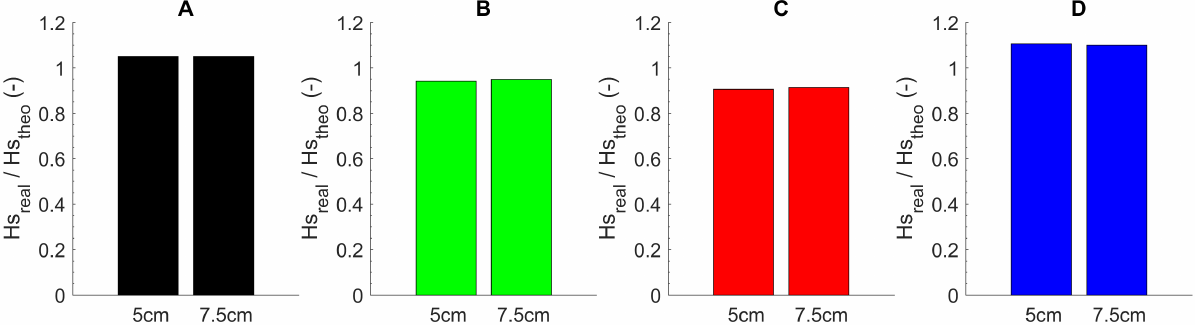
) to theoretical( H s ) significant wave height for targeted JONSWAP T p = 1.29 s, H s = 5 cm real theo